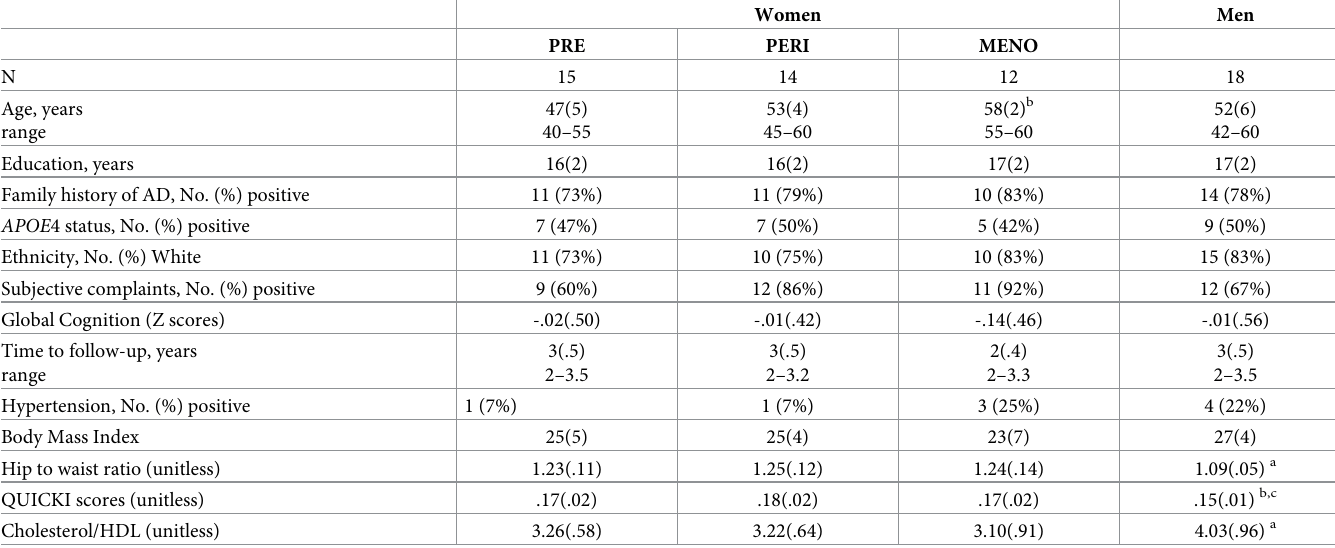
Table 1. Baseline demographic and clinical characteristics by